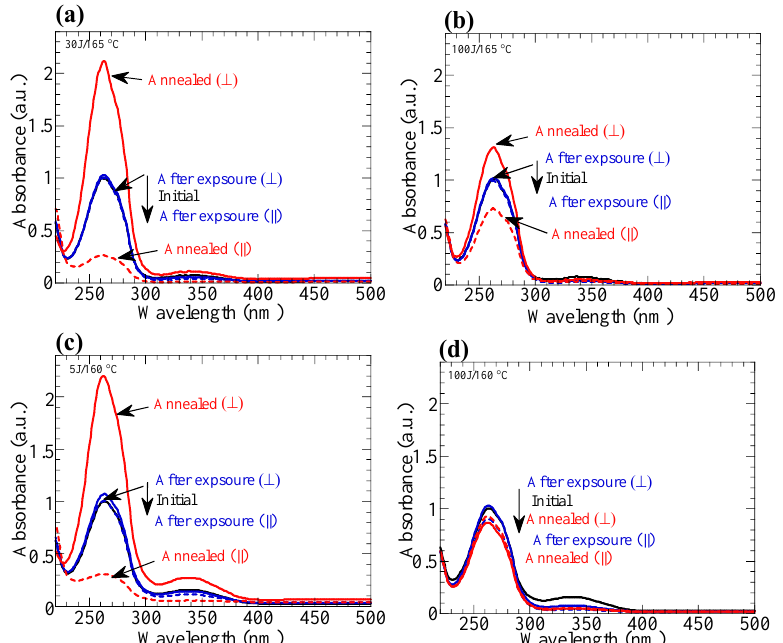
Figure 7. ( a , b ) Changes in the polarized absorption spectra of the PN10 films before (black line) and after exposure (blue lines) to LP 365-nm light for ( a ) 30 J/cm 2 and ( b ) 100 J/cm 2 and subsequent annealing (red lines) at 165 °C for 10 min. ( c , d ) Changes in the polarized absorption spectra of the PN20 films before (black line) and after exposure (blue lines) to LP 365-nm light for ( c ) 5 J/cm 2 and ( d ) 100 J/cm 2 and subsequent annealing (red lines) at 160 °C for 10 min.